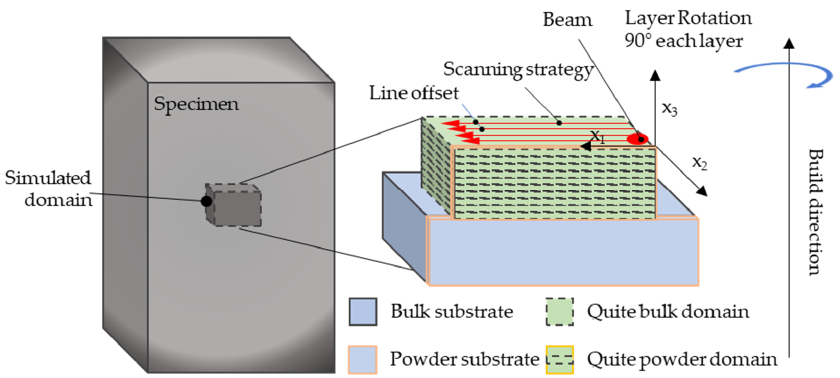
Figure 2. Finite element (FE) model configuration.